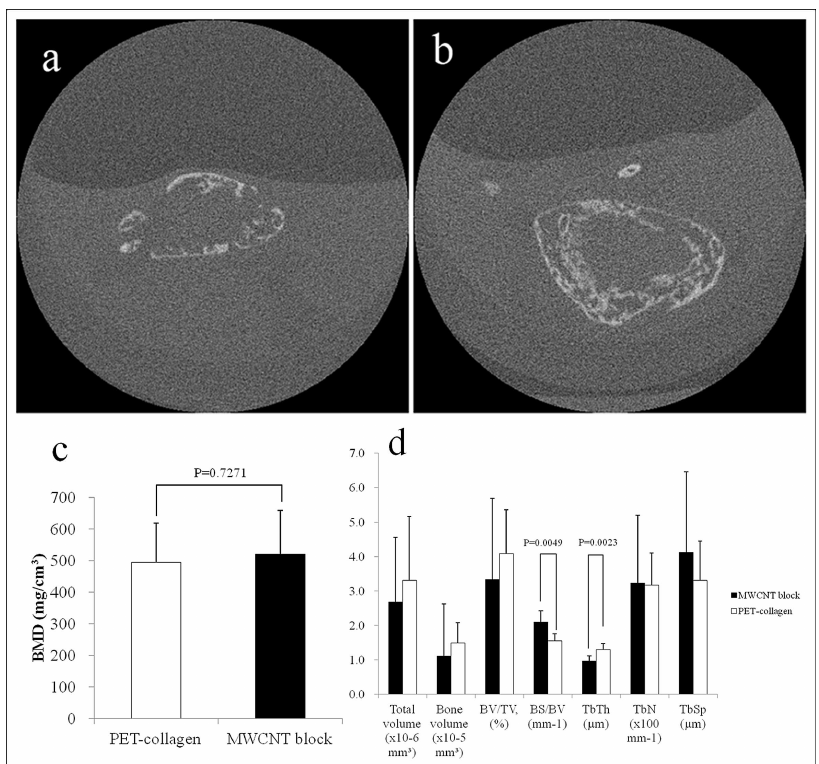
Fig 6. The μ CT evaluation at 3 weeks after implanting rhBMP-2-containing scaffold in the mouse back muscle. (a) CT image of ectopic bone formed using a PET-fiber-reinforcedcollagensheet (positivecontrol) as a scaffold (arrow). (b) CT image of ectopic bone formed using MWCNT blocks. Distinct bone formation was observedin both cases. (c) BMD values of ectopic bone formed aroundan rhBMP-2-containingPET-fiber- reinforcedcollagensheet and rhBMP-2-containingMWCNT block. (d) Three-dimensional μ CT analysis. BV/ TV: bone volume / total volume; BS/BV: bone surface / bone volume; TbTh: trabecularthickness; TbN: trabecular number; TbSp: trabecular